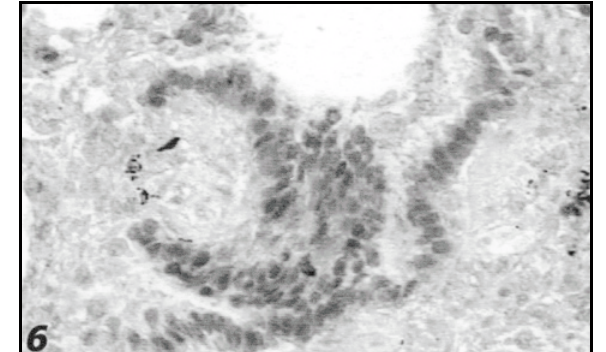
Figure 6 – Lung (pneumocytes), anti-thyroid transcription factor-1 (TTF1), nuclear staining (x 800)